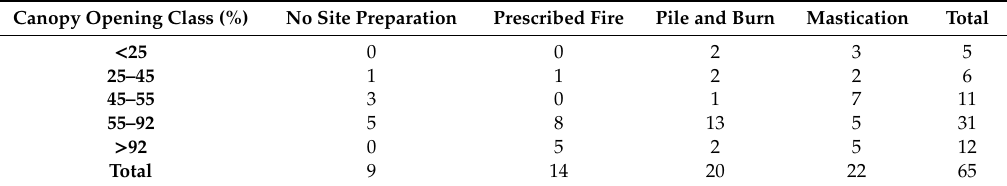
Table 1. Number of plots within the canopy opening and site preparation